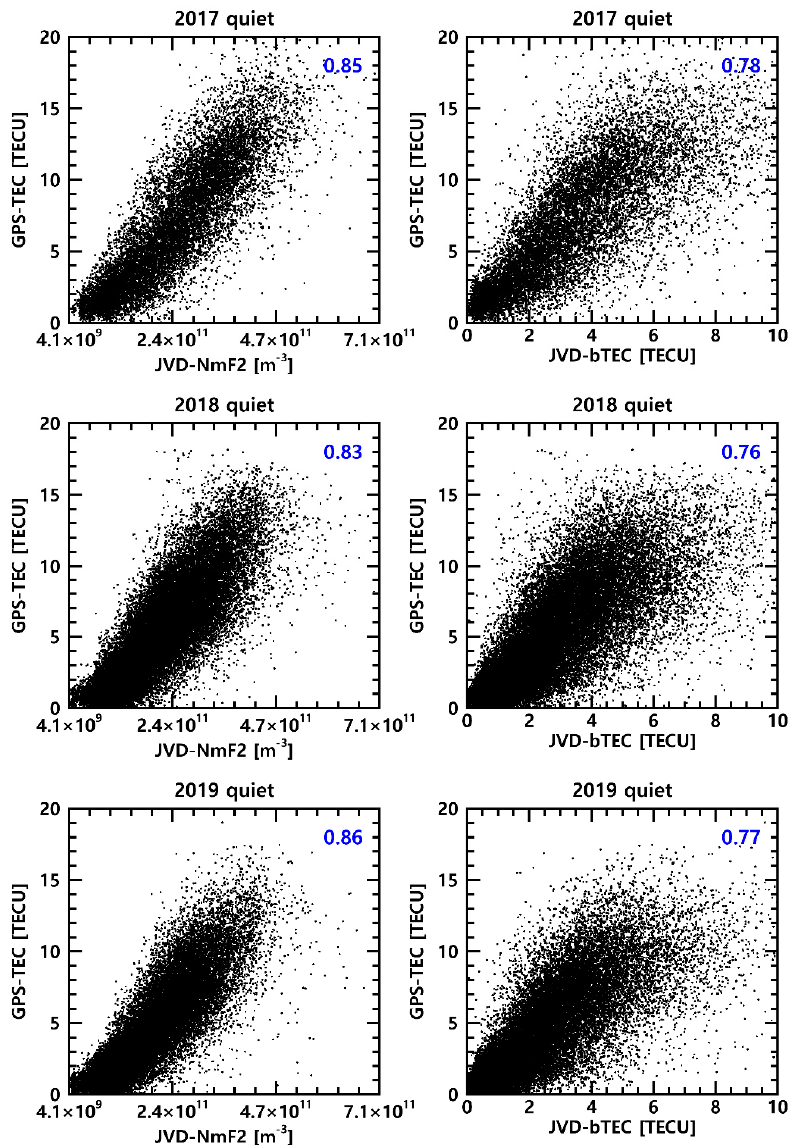
Figure 2. The scatter plot of JVD NmF2 ( left ) and bottom bTEC ( right ) vs. GPS TEC averaged for 10 min during quiet time from 2017 (top) to 2019 (bottom). The linear correlation coefficients for each case are shown at the upper right − corner of the panels.